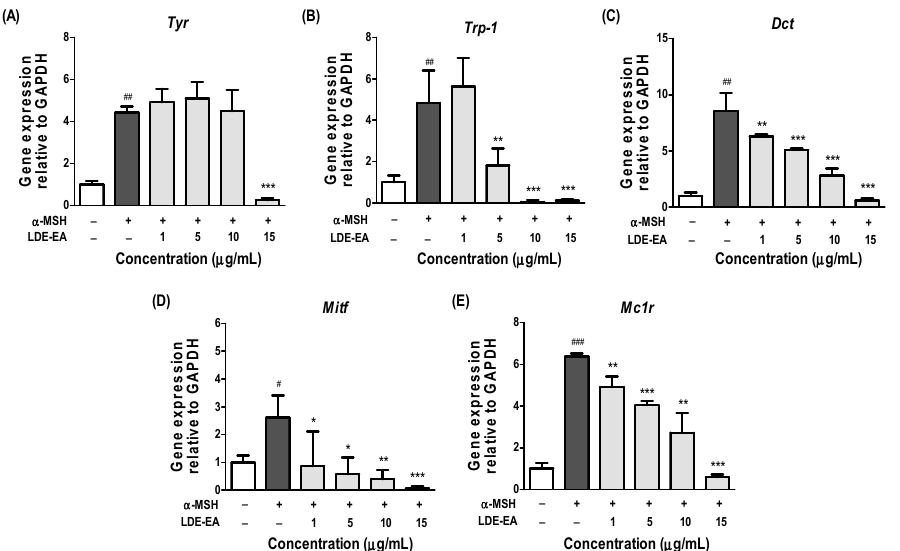
Figure 4. Effects of LDE-EA on mRNA expression of Tyr , Trp-1, Dct, Mitf , and Mc1r in B16F10 cells stimulated with α -MSH. B16F10 cells were co-treated with LDE-EA and 200 nM α -MSH. After treatment, the mRNA expression of Tyr ( A ), Trp-1 ( B ), Dct ( C ), Mitf ( D ), and Mc1r ( E ) was measured and normalized to GAPDH expression. Values are represented as the mean ± SEM of three independent experiments. Note: # p < 0.05, ## p < 0.01, and ### p < 0.001 compared with the control group; * p < 0.05, ** p < 0.01, and *** p < 0.001 compared with the α -MSH-treated group.